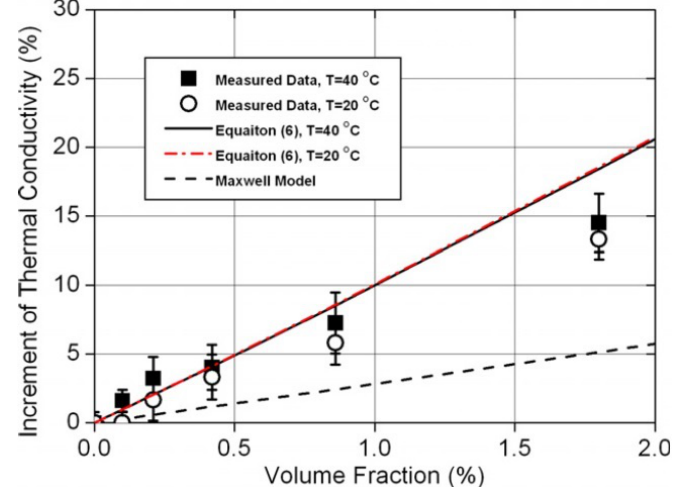
Figure 2. Thermal conductivity enhancement for TiO 2 nanoparticles dispersed in pure ethylene-glycol at two temperatures 20 and 40 ◦ C. After [52], with permission from